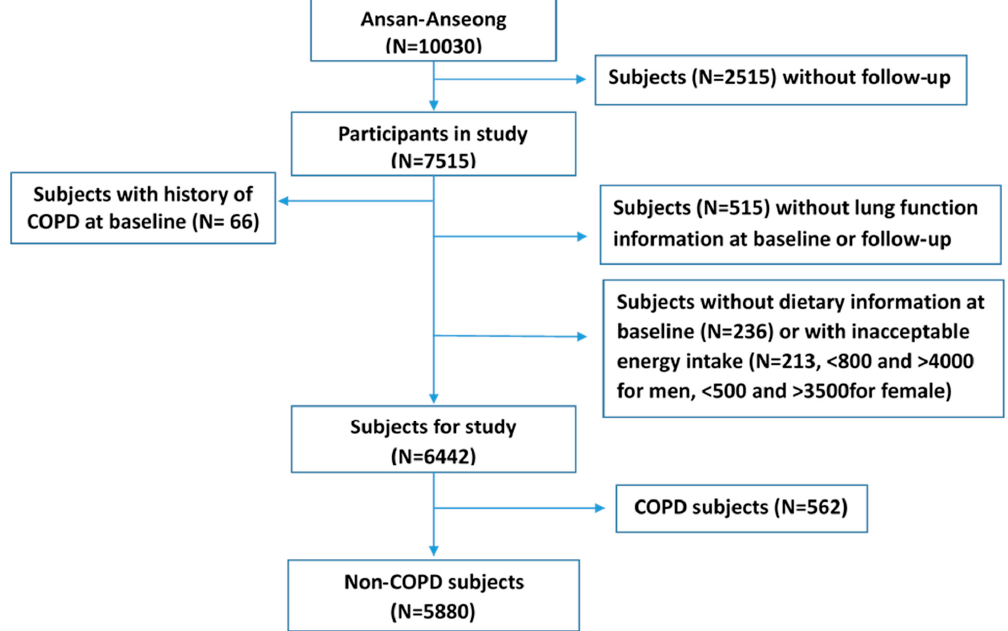
Figure 1. Flow diagram of analytical sample in current study using KoGES_Ansan and Ansung cohort. COPD: Chronic Obstructive Pulmonary